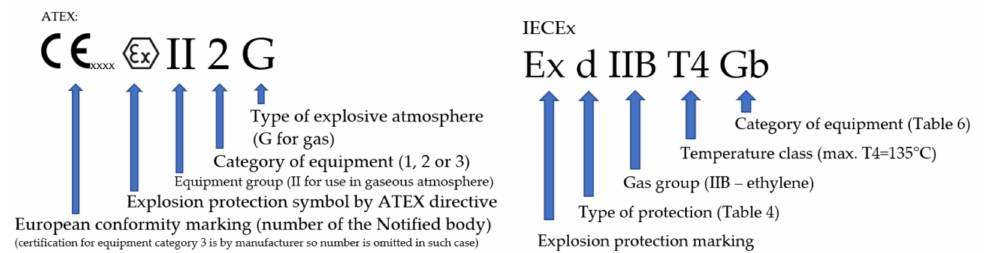
Figure 2. Marking according to the ATEX and the IECEx schemes for protection against